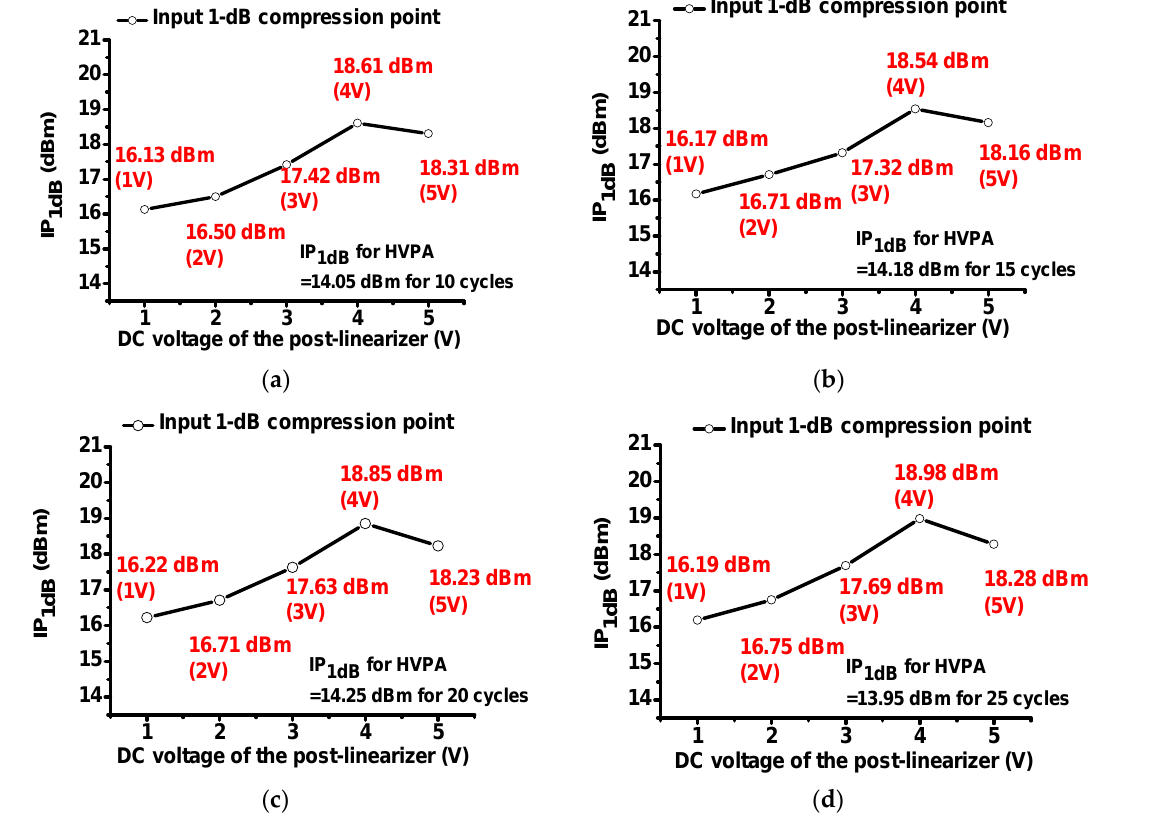
Figure 7. Output power vs. input power of the HVPA without the post ‐ linearizer (value provided in each figure) and HVPA with post ‐ linearizer (solid black lines) with 10 MHz, ( a ) 10 ‐ , ( b ) 15 ‐ , ( c ) 20 ‐ , and ( d ) 25 ‐ cycle pulse signals sent to the HVPA with and without the post ‐ linearizer, respectively.